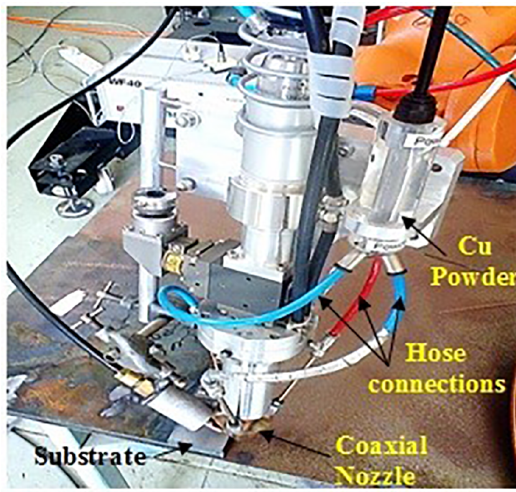
Figure 1. Schematic view of the nozzle head 15 The nozzle is connected to a laser robotic arm. Both the powder and the laser beam were ejected at the end of the nozzle and laser deposit on the substrate to form the solidified metal. Pure Cu powder and Ti6Al4V alloy substrate were used for the laser experiment. The Cu powder is fed via a hopper - a powder feeder capillary which is connected to the nozzle via long hoses. The particle sizes of the pure Cu powder are between 100 and 200 µm. The argon gas was supplied at 10 l/min to provide a shield for the deposited Cu during the operation so as to prevent oxygen contamination. A square plate of Ti6Al4V alloy was used as the substrate. It was sand blasted to purify the surface and to prepare it for metallographic bonding. The blasted surface was cleaned with acetone and dried off.